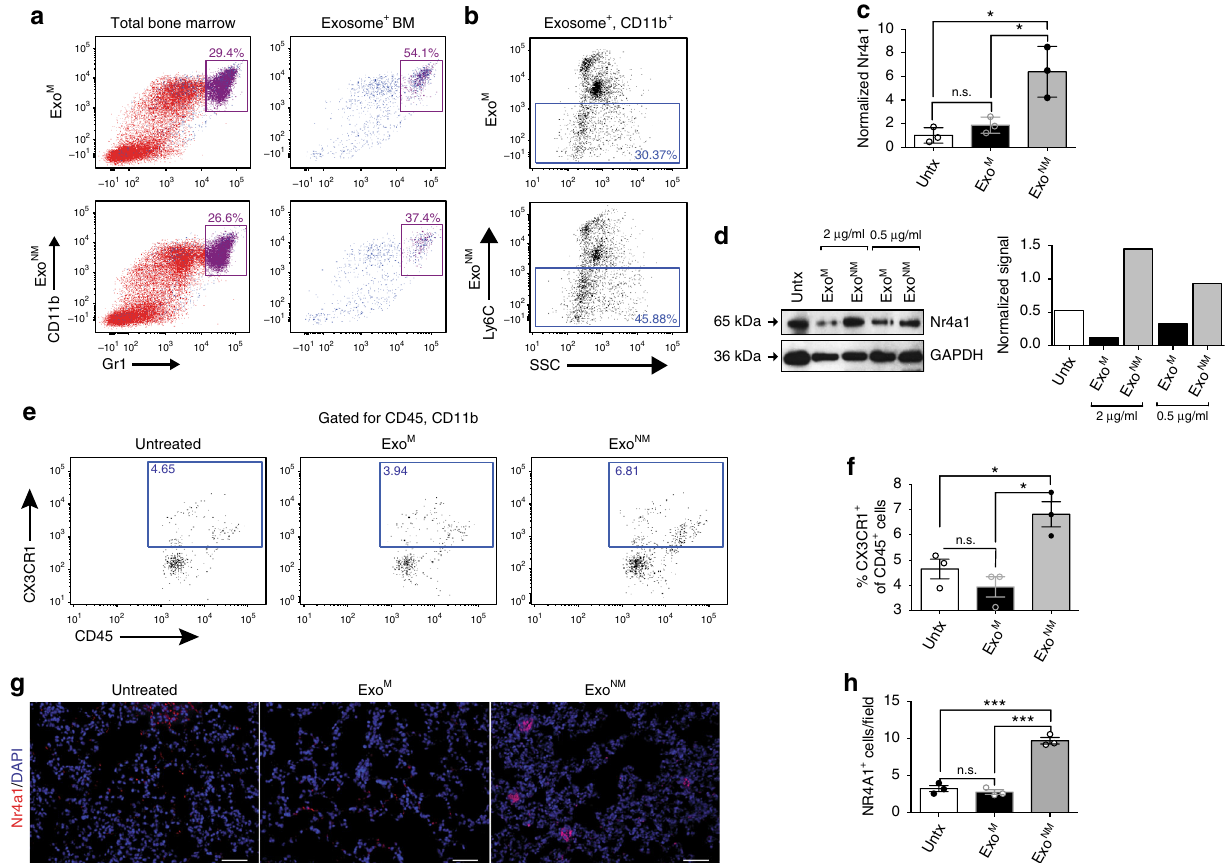
Fig. 2 Exo NM increase PMo population. C57BL/6 mice were treated with Exo M or Exo NM , prior to BM isolation. a Flow cytometry shows the uptake of fl uorophore-tagged exosomes by the myeloid cells in the BM. Left: Flow plots of the total CD11b + Gr1 + BM populations. Right: Plots show a higher percentage of CD11b + Gr1 + cells among the BM cells positive for exosome uptake. A representative of three independent experiments is shown. b Treatment with Exo NM leads to an increase in Ly6C low CD11b + cells compared to Exo M in the total myeloid population. c qRT-PCR of mRNA encoding Nr4a1. Mouse BM monocytes were treated 24 h with exosomes (10 μ g ml − 1 ). The experiment was performed in biological triplicates and technical replicates of two. * P < 0.05 by t -test in pairwise comparisons. Averages and s.d. values shown. d Western blot shows an increase in Nr4a1 in mouse BM monocytes treated with Exo NM . Quanti fi cation was performed using ImageJ (National Institutes of Health), utilizing plot pro fi le (areas under the peaks) and integrated density measures. A representative of three experiments is shown. e – h Exosomes increase the presence of PMo in the lung. C57BL/6 mice were treated with 10 μ g Exo NM or Exo M 72 and 24 h prior to sacri fi ce. CX3CR1 + cells present in the lung were detected by FACS or in situ IF. e Mouse lungs were lavaged, smashed through a strainer and single-cell suspension stained for CD11b, CD45, and CX3CR1. FACS plots were gated for CD11b + CD45 + cells and CX3CR1 + cells quanti fi ed. f Quanti fi cation of the data shown in a (percent CX3CR1 + of total CD45 + cells). * P < 0.05 calculated as above. Mean and s.d. values are shown. g IF analysis shows the increased abundance of Nr4a1 + cells in the lungs of mice treated with Exo NM . Scale bar, 100 μ m. h Quanti fi cation of the data in g , expressed as number of Nr4a1 + cells fi eld − 1 . Scale bar: 50 μ m. n = 3 mice per group, fi ve images per section. * P < 0.05, ** P < 0.001, and *** P < 0.0005 by pairwise two-tailed t -test; n = 5 mice per group, > 5 random images per lung. Mean and s.d. values are Monocytes are necessary for anti-metastatic action of Exo NM . Furthermore, PMo express high levels of CX3CR1, which mediates their interactions with the vasculature 36,39 and anti- in the BM (Fig. 2a, Supplementary Fig. 5c), we assessed the metastatic activity 37 . This led us to assess the CX3CR1 + monocytes in the lungs of mice after pre-treatment with Exo NM or Exo M . Flow cytometry analysis reveals low numbers of CD45 + CX3CR1 + cells in the lungs of mice treated with control vehicle in the lungs of mice subjected to monocyte depletion using liposome-encapsulated clodronate 53, 54 . The depletion is con- or Exo M . In contrast, there is a signi fi cant increase in CX3CR1 fi rmed by staining of the lung tissue for the pan-macrophage (F4/ + CD45 + monocytes in the lungs of mice treated with Exo NM (Fig. 2e, f). The results are con fi rmed by immuno fl uorescence (IF) 80) and myeloid (CD11b) markers (Fig. 3a and Supplementary staining of the lung sections of mice treated with control vehicle, Fig. 8a, b, respectively). After monocyte depletion, animals were Ex M or Ex NM for PMo marker Nr4a1 (Fig. 2g, h). pre-conditioned with exosomes (three injections, 10 μ g per ani- PMo are characterized by their ability to “ crawl ” along the mal) and inoculated, via the tail vein, with B16F10 melanoma vasculature in a process which requires the LFA-1 antigen, a cells. Consistent with previous observations 44 , lung imaging 24 h post-inoculation shows increased lung colonization in mice pre- complex of CD11a and integrin β 2 (ITGB2). Consistent with the conditioned with Exo M compared to the baseline. In contrast, shift toward PMo phenotype, Exo NM upregulates ITGB2 in THP-1 monocytes (Supplementary Fig. 7). pre-conditioning with Exo NM causes a signi fi cant and